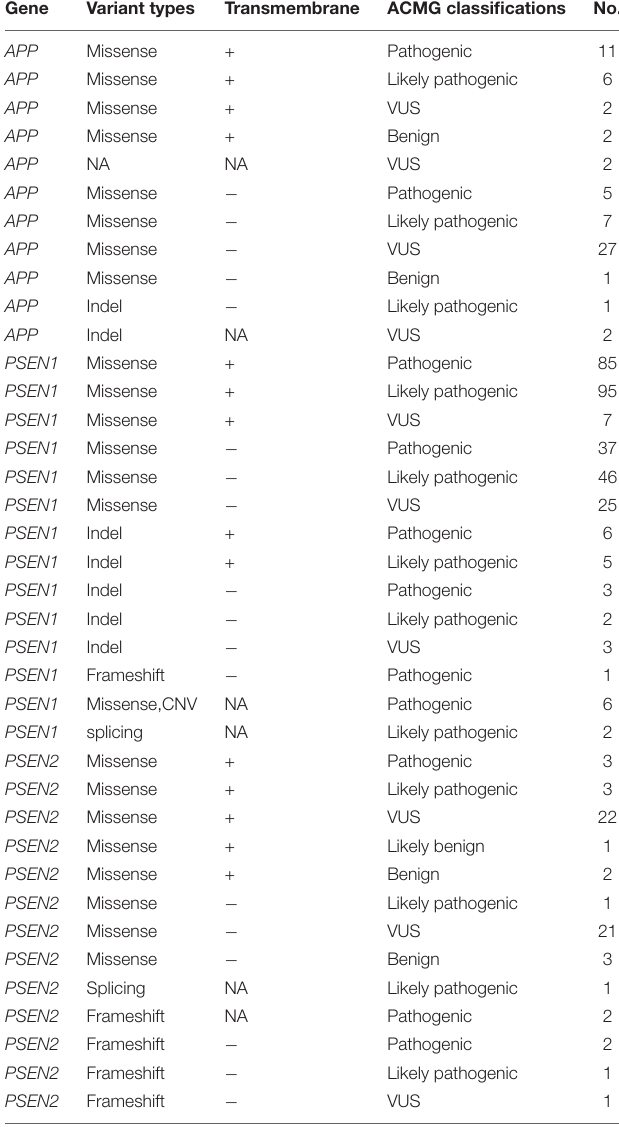
TABLE 2 | ACMG classifications of three pathogenic variants in